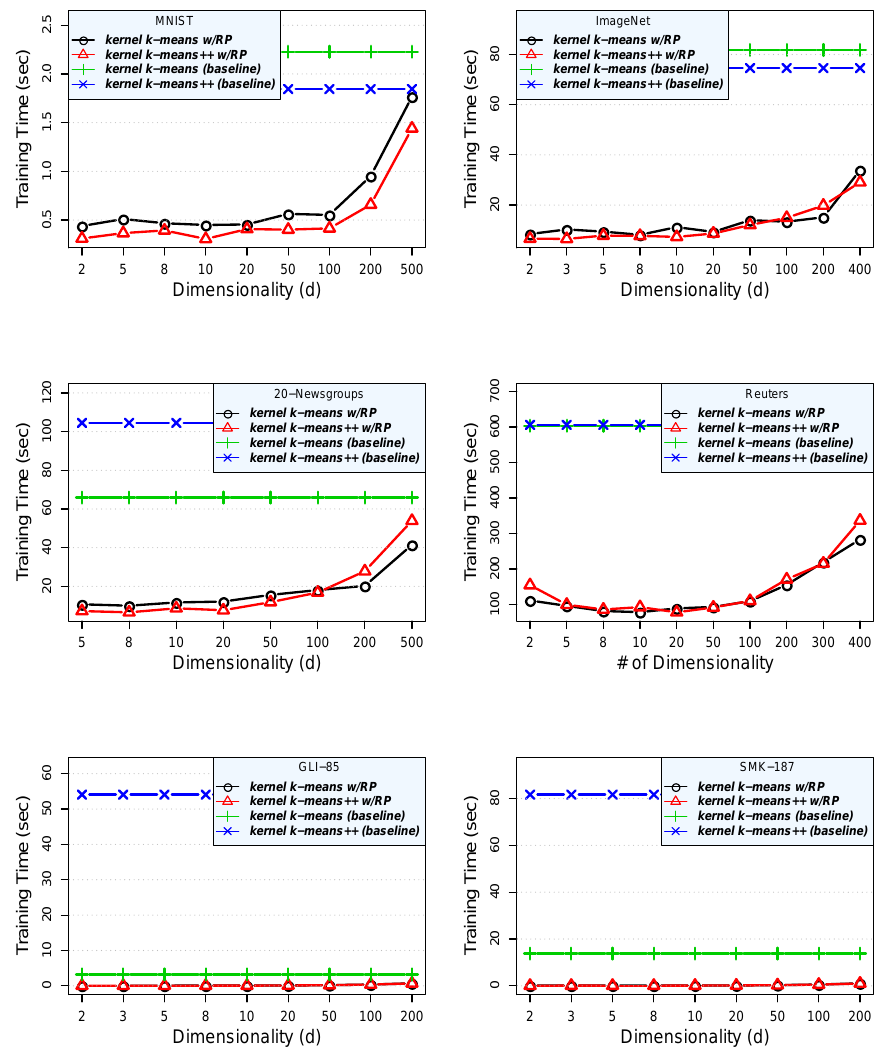
Figure 4. Reduced training